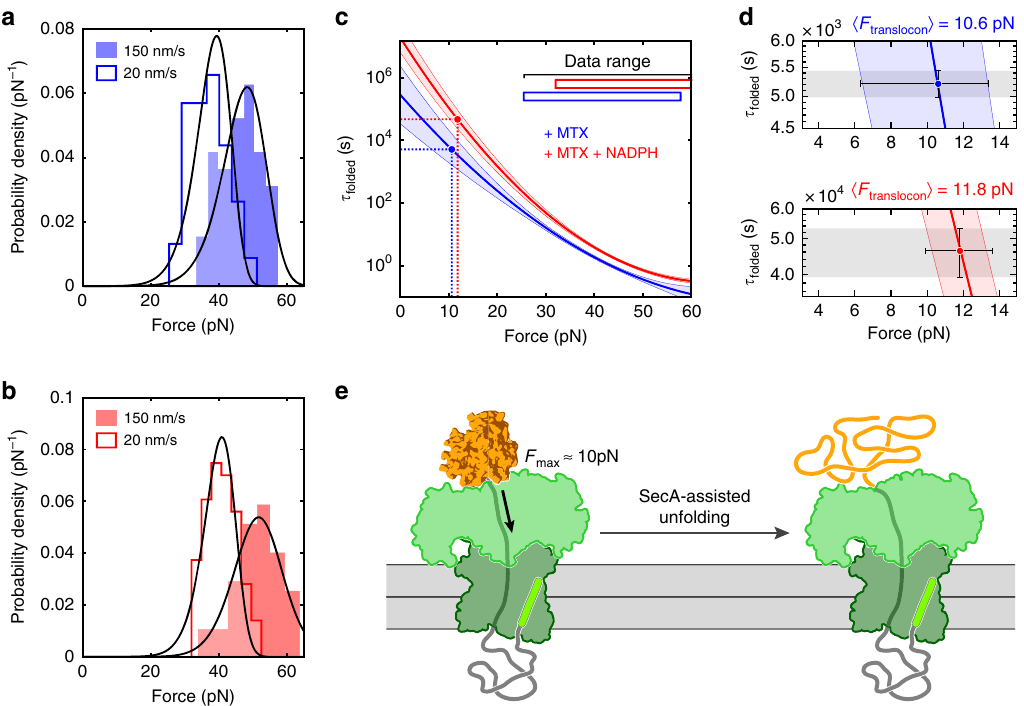
Fig. 4 The translocon generates mechanical force to unfold mDHFR. a , b Histograms of unfolding force distributions for single- ( a ) and double- ( b ) liganded mDHFR at two pulling speeds. The distributions at a trap velocity of 150nms − 1 ( fi lled) are the same as in Fig. 3. At a lower trap velocity of 20nms − 1 , unfolding occurs on average at lower forces. Solid lines represent probability densities reconstructed using a Kramers-like model with parameters obtained from maximum-likelihood analysis of the transformed experimental data. c Dependence of the folded state lifetime of mDHFR ( τ folded ) on force in the presence of MTX (blue) and MTX + NADPH (red). Solid lines are the means obtained from fi tting the unfolding force distributions, the shaded regions represent the random error (standard deviation). The range of experimentally available data ( “ data range ” ) is indicated by horizontal bars. Solid circles indicate the folded state lifetimes from translocation experiments. In both ligand conditions, similar values for the corresponding forces are obtained (dashed lines). d Close-up of the folded-state lifetimes. Colored lines and shaded areas as in ( c ). The gray shaded area and vertical error bars represent the uncertainty in folded state lifetimes from translocation measurements. The horizontal error bars represent the uncertainty in the translocon force, obtained by relating the translocation and single-molecule force spectroscopy results. All error bars represent standard deviations. e Schematic illustrating the direction and magnitude of force applied by SecA during translocation of proOmpA-mDHFR. Source data are provided as a Source Data fi le.